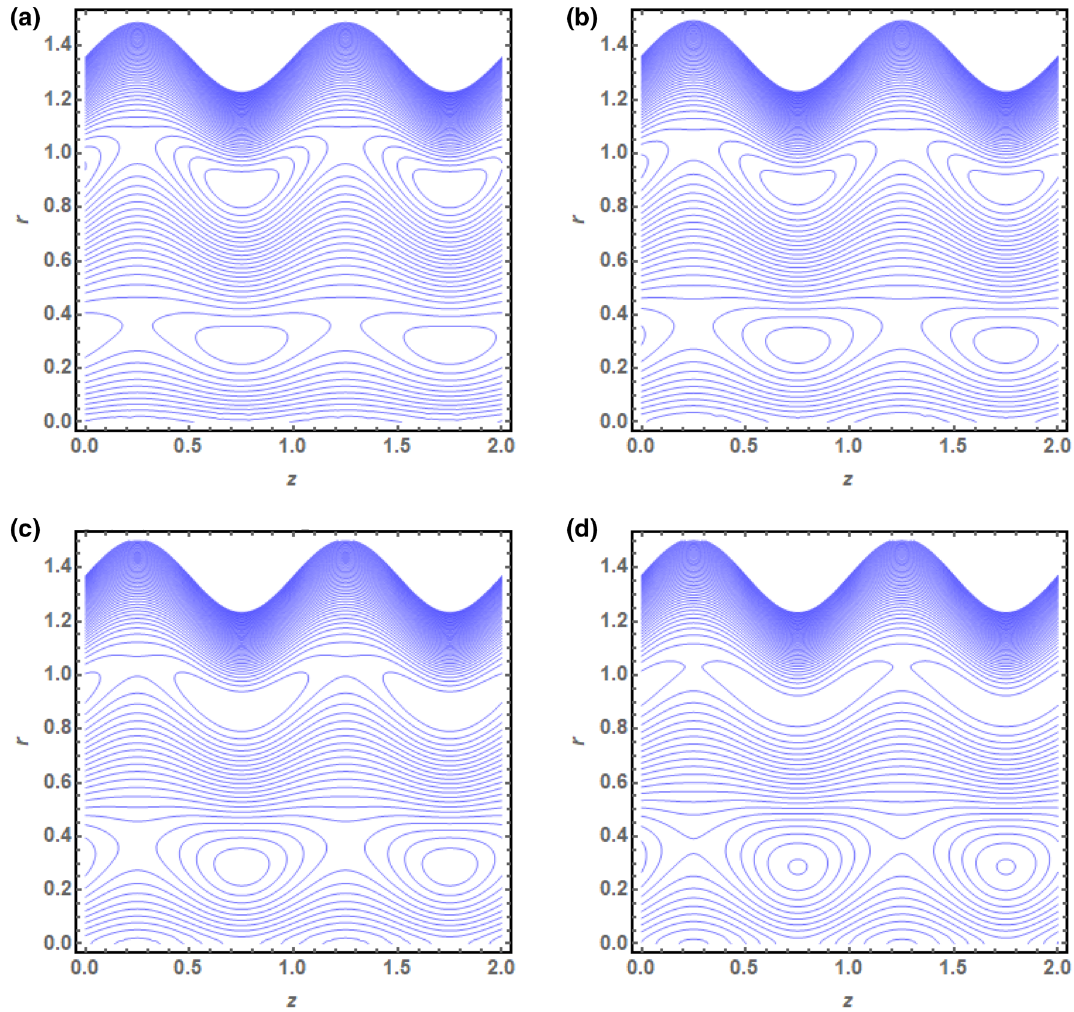
Figure 6. ( a ) Streamline plot for s = 0.01 . ( b ) Streamline plot for s = 0.02 . ( c ) Streamline plot for s = 0.03 . ( d ) Streamline plot for s = 0.04